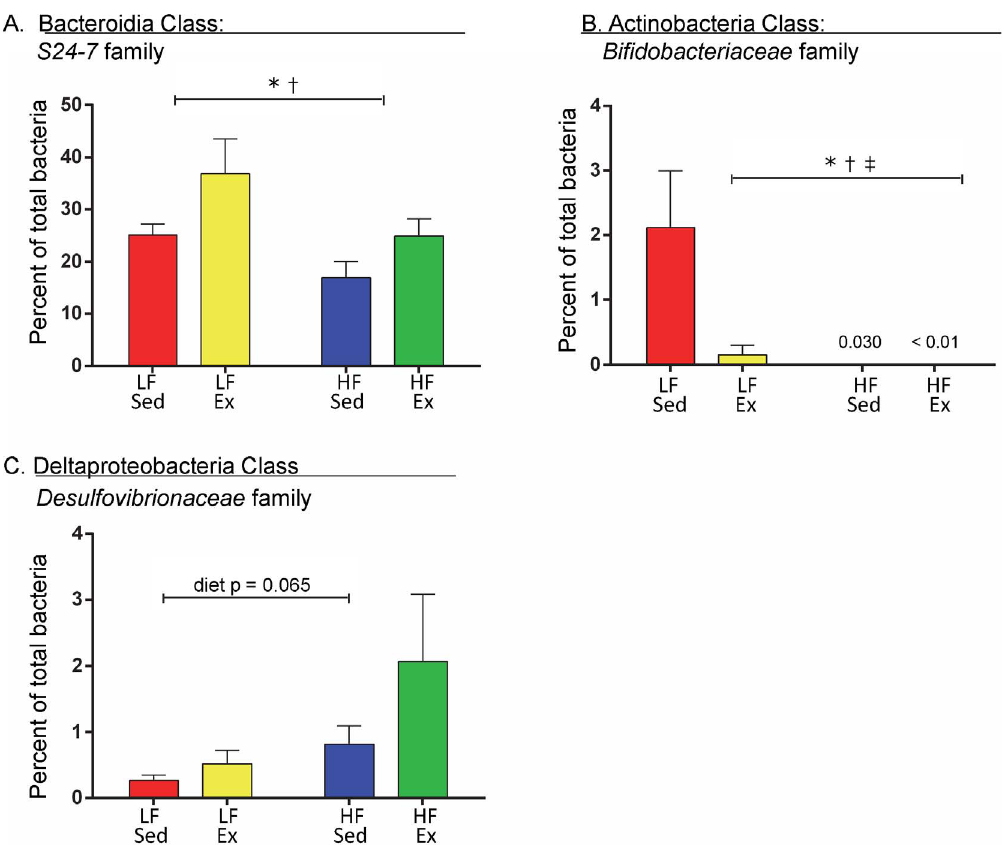
Figure 8. Diet and Activity Altered Families within the Bacteroidetes, Actinobacteria and Proteobacteria Phyla. Family level taxonomic groups were identified from sequencing 16S rDNA at week 12 of the diet and activity protocol. A. Within the phylum Bacteroidetes, the class Bacteroidia had one family that was altered by diet and activity: S24-7 . B. Within the Actinobacteria phylum and class, one family was altered by diet and activity: Bifidobacteriaceae . C. Within the Proteobacteria phylum, the class Deltaproteobacteria had one family that demonstrated a trend toward an effect of diet and activity: Desulfovibrionaceae . Data were analyzed by 2-way ANOVA with a Sidak post hoc test. Significant differences indicated as follows: ‘‘*’’ p , 0.05 for diet effect, ‘‘ { ’’ p , 0.05 activity effect and ‘‘ ` ’’ p , 0.05 diet and activity interaction. n=6 mice/group.